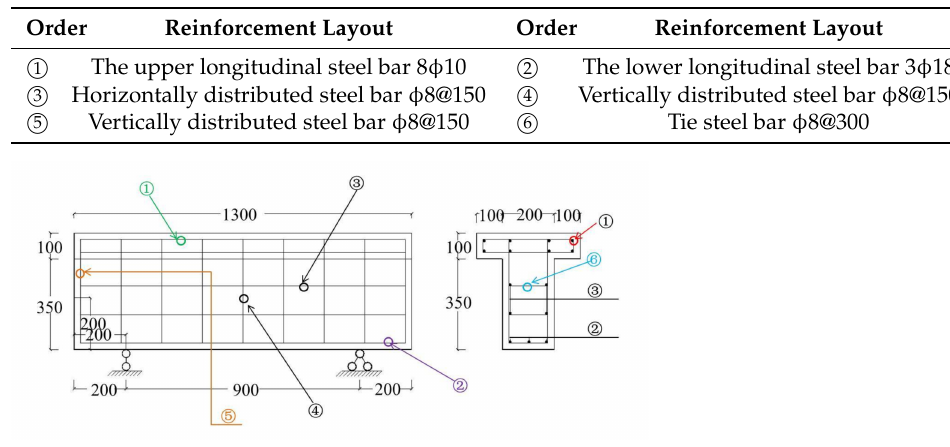
Figure 8. Layout of deep T-beam. Note: Size unit: